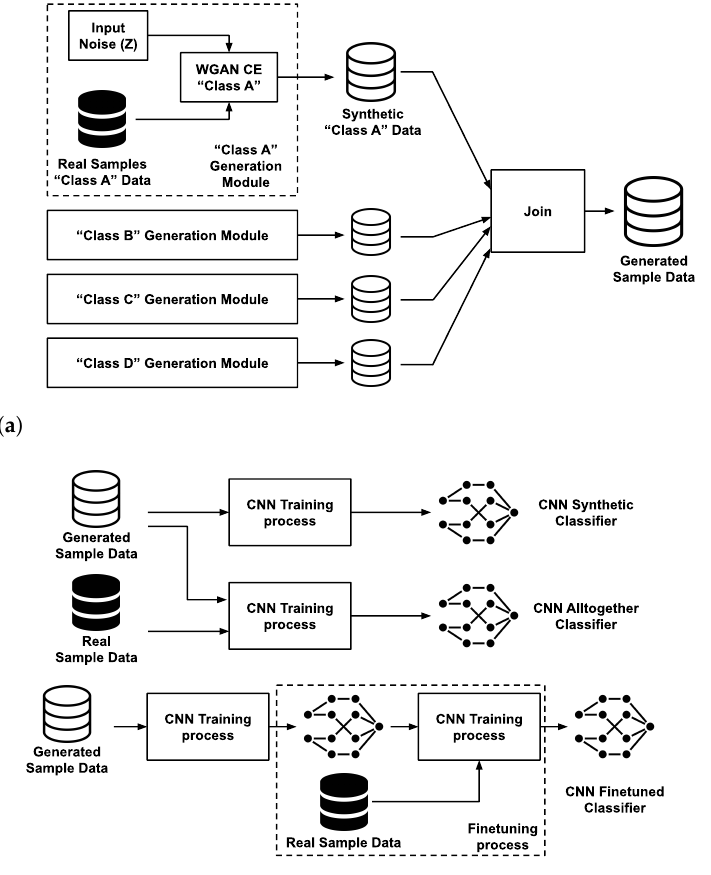
Figure 5. Proposed CNN-based classifier development: ( a ) synthetic data generation step through class-expert training of the adversarial models (expert WGANs) and ( b ) classification step by em- ploying CNNs, which were trained on both synthetic and experimental data by using either a mixed data training procedure or fine-tuning the synthetic data-based classifier with experimental data for a final